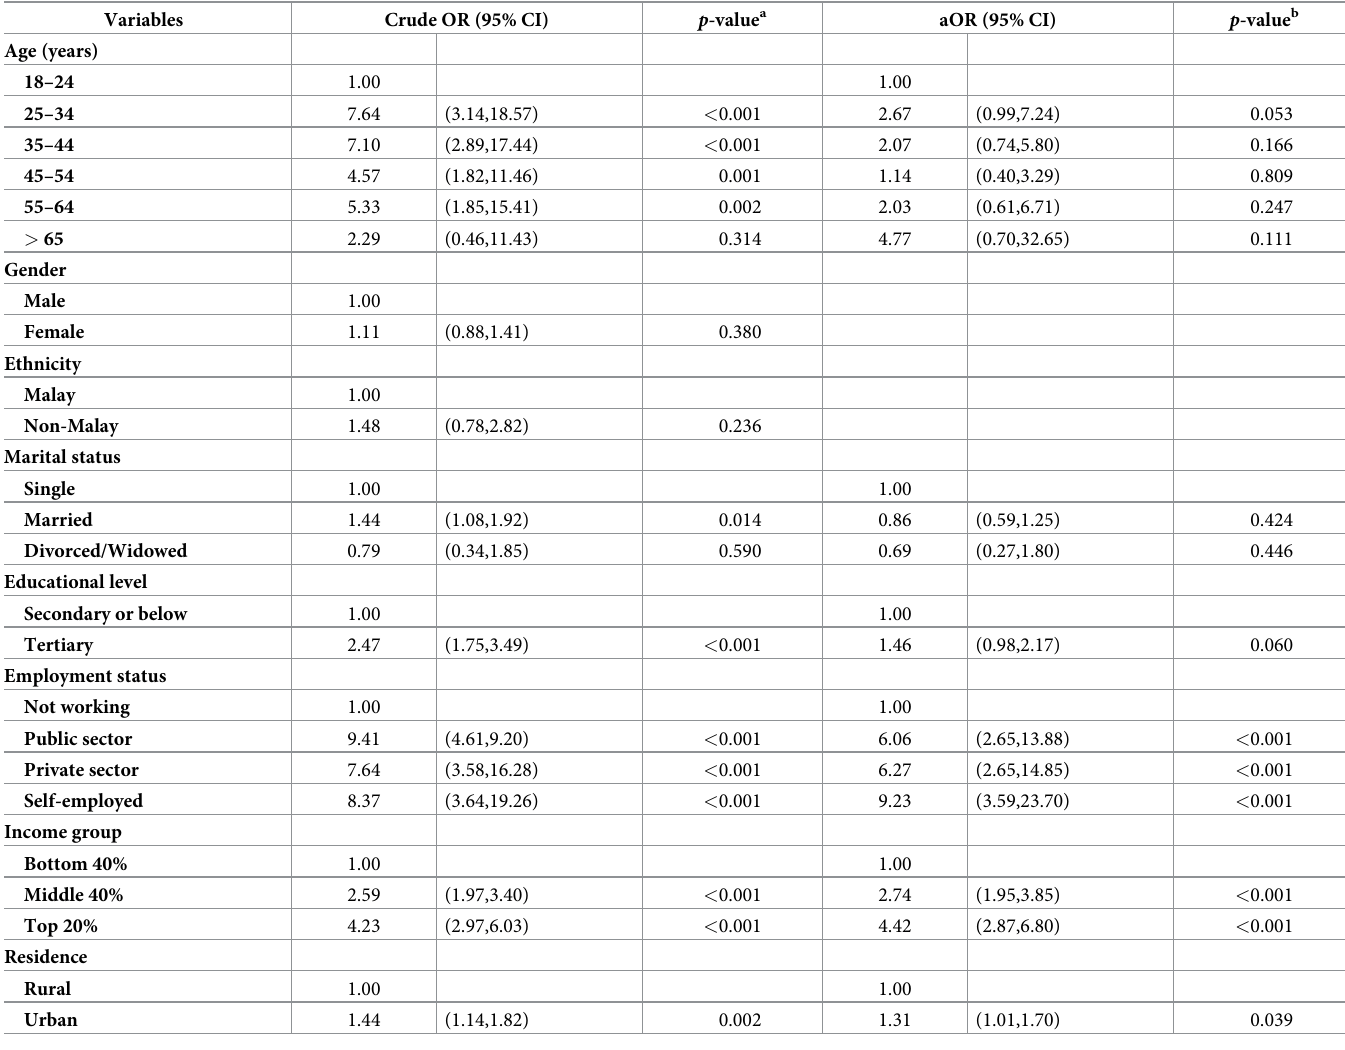
Table 2. Logistic regression analysis of determinants of private health insurance